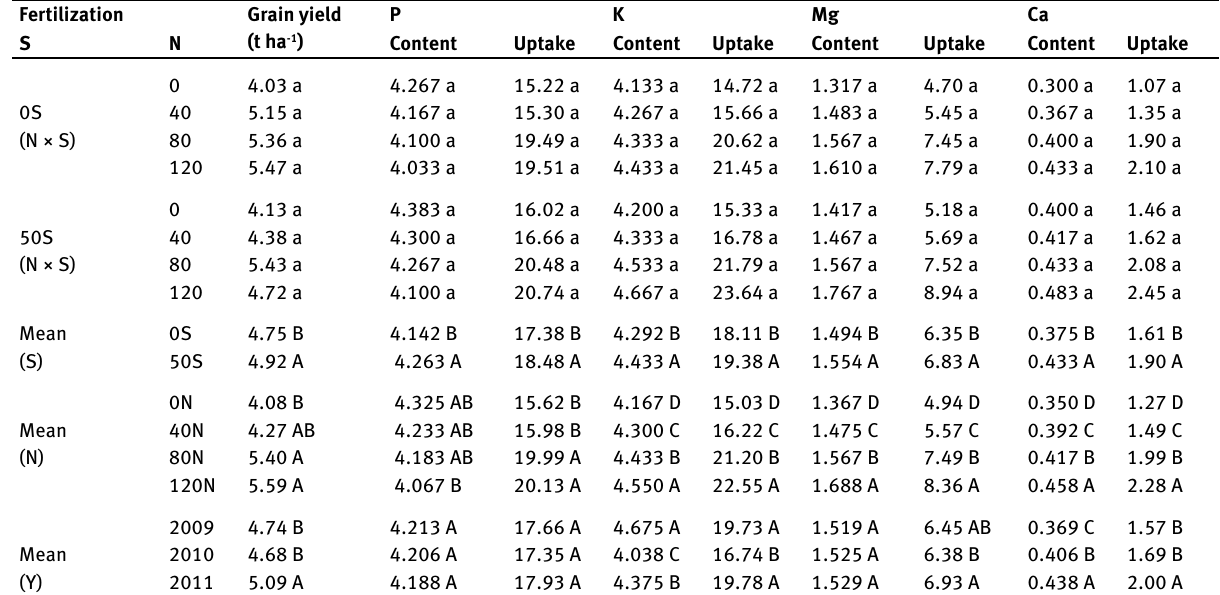
Table 2: The influence of nitrogen and sulphur fertilization on content (g kg -1 ) of macroelements in the spring wheat grain and their uptake (kg ha -1 ) .